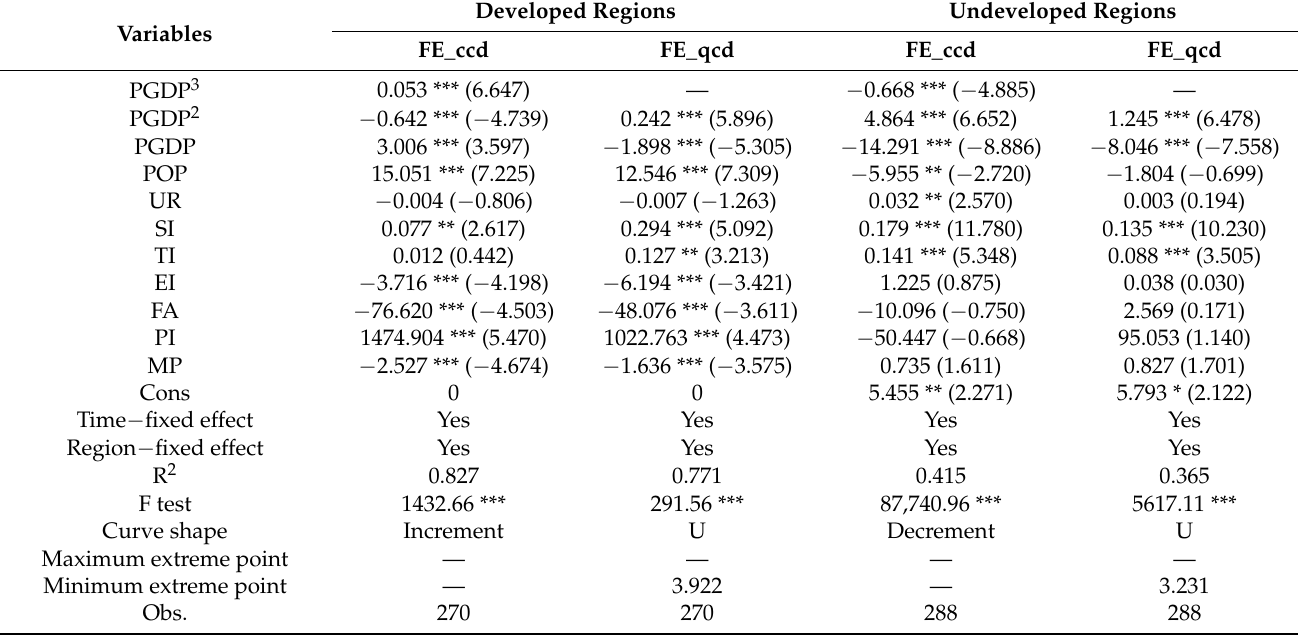
Table 10. Estimation results for different economic development regions.